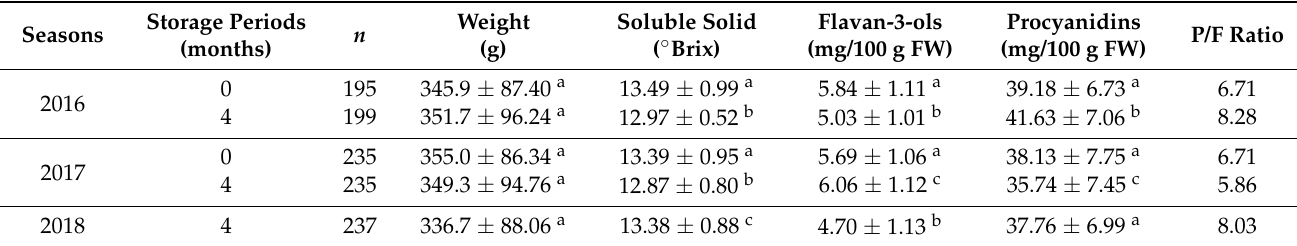
Values are means ± standard deviation. P/F refers to the procyanidins to flavan-3-ols ratio. Flavan-3-ols and procyanidins were equated to (–)-epicatechin and procyanidin B2, respectively. The mean values within a verse with different letters are significantly different at p < 0.05 according to Tukey’s multiple comparisons